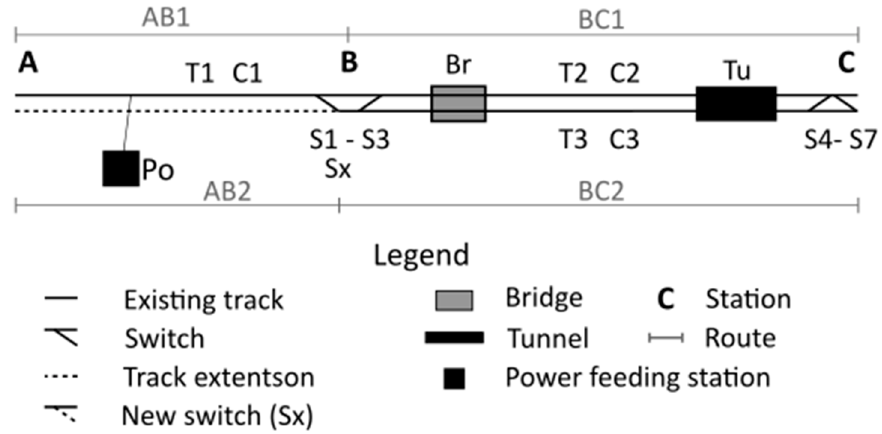
Infrastructures 2020 , 5 , x FOR PEER REVIEW Figure 2. Process to construct the system model. Figure 2. Process to construct the system model.